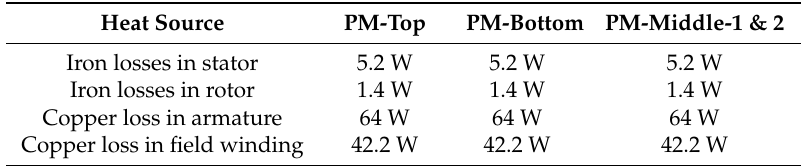
Table 6. Heat sources when ferrite is employed.